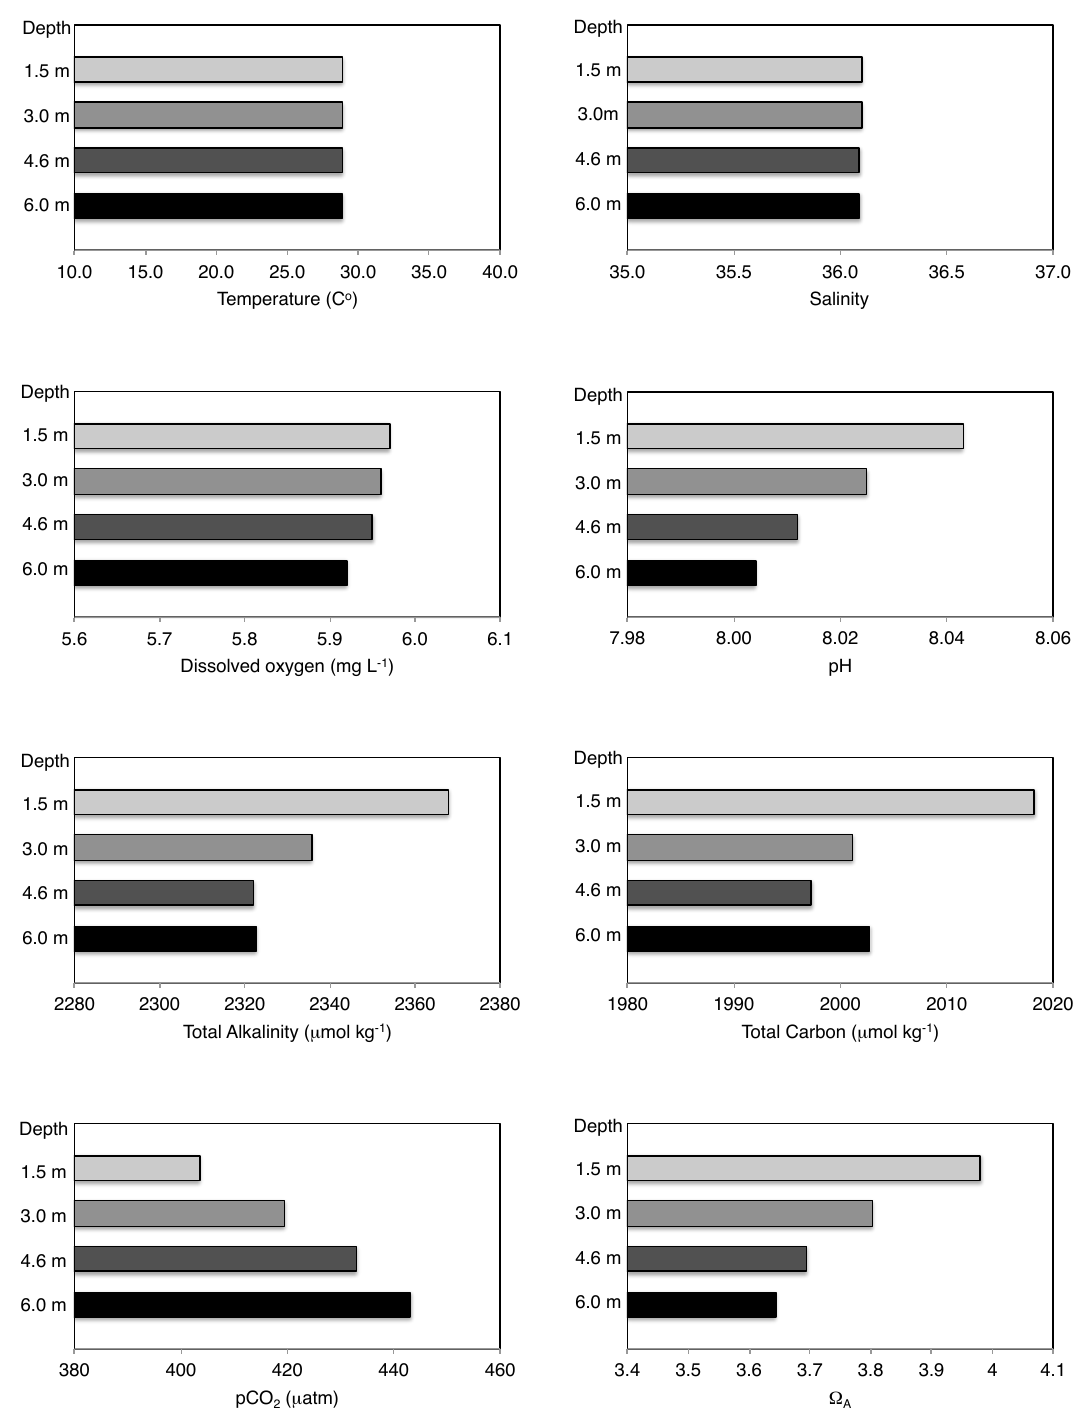
Figure 4. Vertical profile data of seawater chemical parameters collected at 07:00 on 19 July 2011 over coral habitat at 6.5m water depth. Vertical axis is depth below sea surface. Also refer to Table